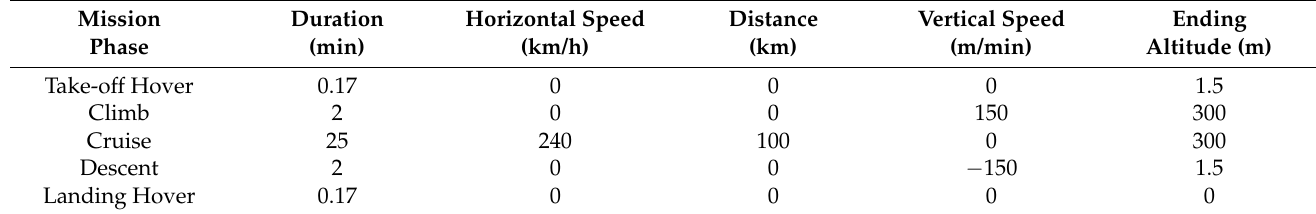
Table 3. The mission settings for a typical UAM flight. Adapted from Uber